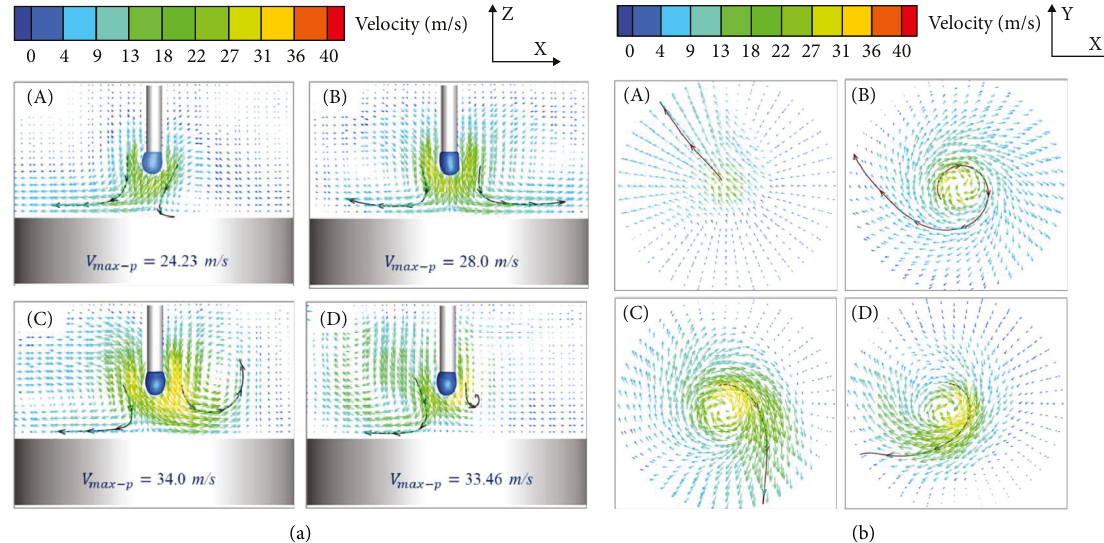
Figure 18: (a) Arc plasma flow characteristics at Y � 0 section at t � 14ms under different magnetic flux densities: (A) 0mT; (B) 1 mT; (C) 2mT; (D) 4mT. (b) The arc plasma flow characteristics at Z � 7.5mm section at t � 14ms under different magnetic flux densities: (A) 0mT; (B) 1mT; (C) 2 mT; (D) 4mT.